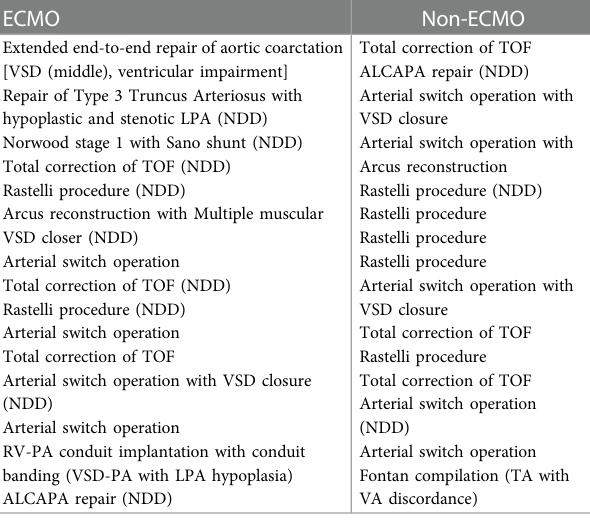
TABLE 1 Procedures and patients with neurodevelopmental